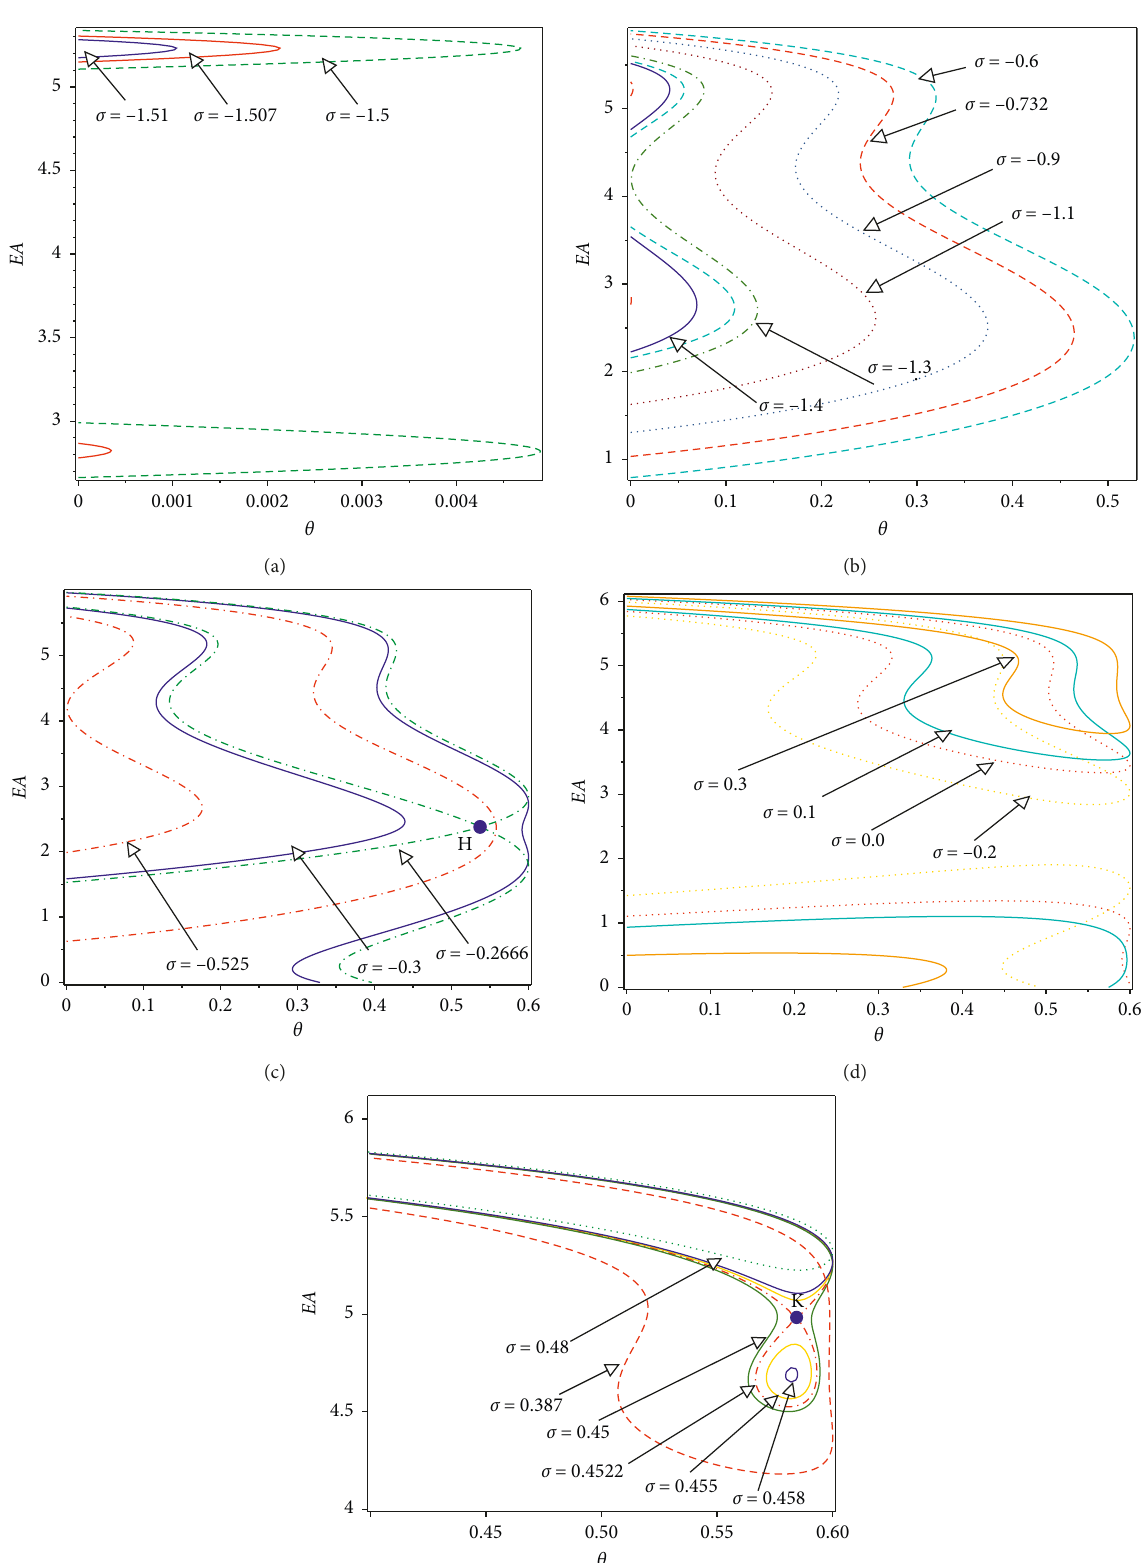
Figure 6: Steady-state moments of the multistable energy harvester under different detuning parameters versus θ